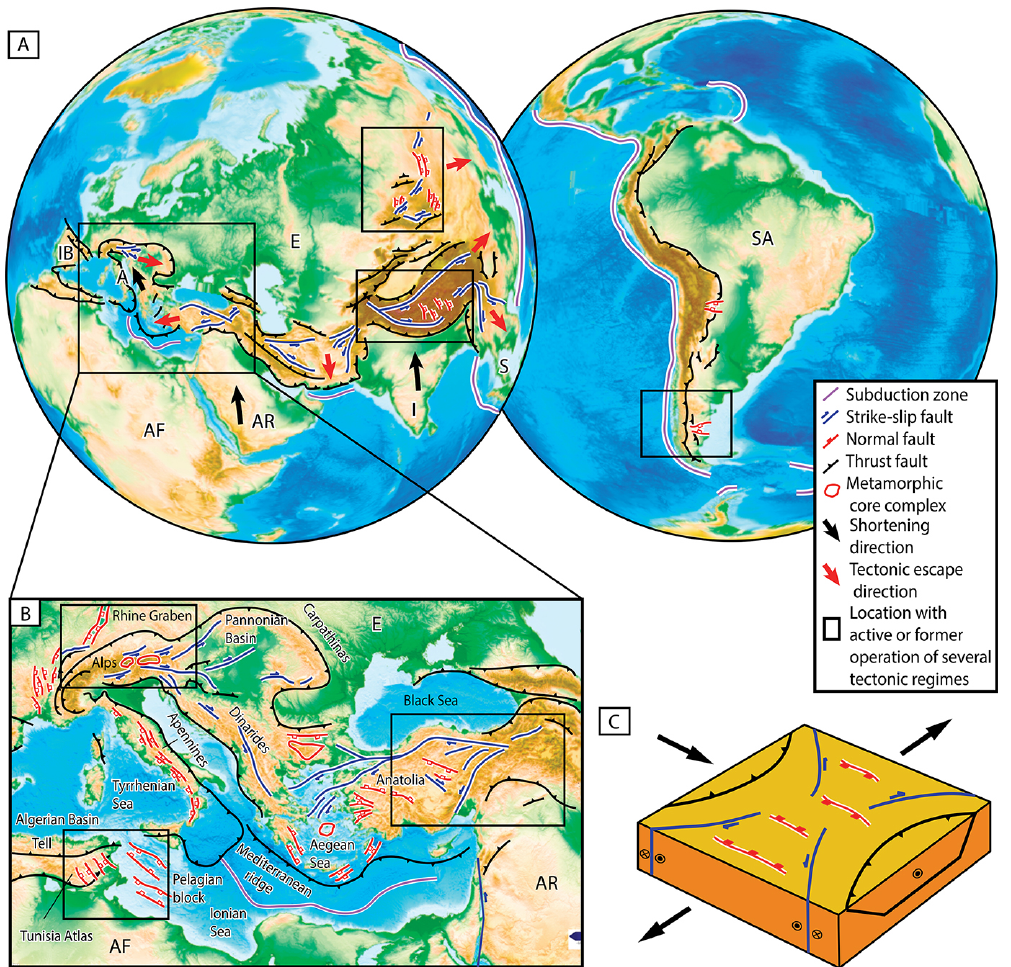
Figure 1. (a) Geological sketch maps showing locations with active or past multiple coeval tectonic regimes (Tapponnier et al., 1982, 2001; Davy and Cobbold, 1988; Martinod et al., 2000; Fournier et al., 2004; Corti et al., 2006; Scharf et al., 2013; Sengör, 1976; Dèzes et al., 2004; Gianni et al., 2015). (b) Close-up map showing the tectonic setting of the Alpine–Mediterranean region. Structures are modified from Faccenna et al. (2014). (c) Block diagram illustrating typical structures formed in settings involving coeval shortening and extension. Abbreviations are as follows: SA, South American plate; I, Indian plate; E, Eurasian plate; AF, African plate; AR, Arabian plate; IB, Iberian plate; A, Adria